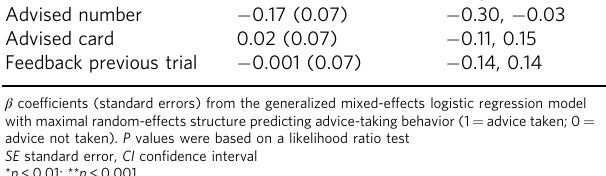
signi fi cant, linear decrease in trust in the advice of dishonest